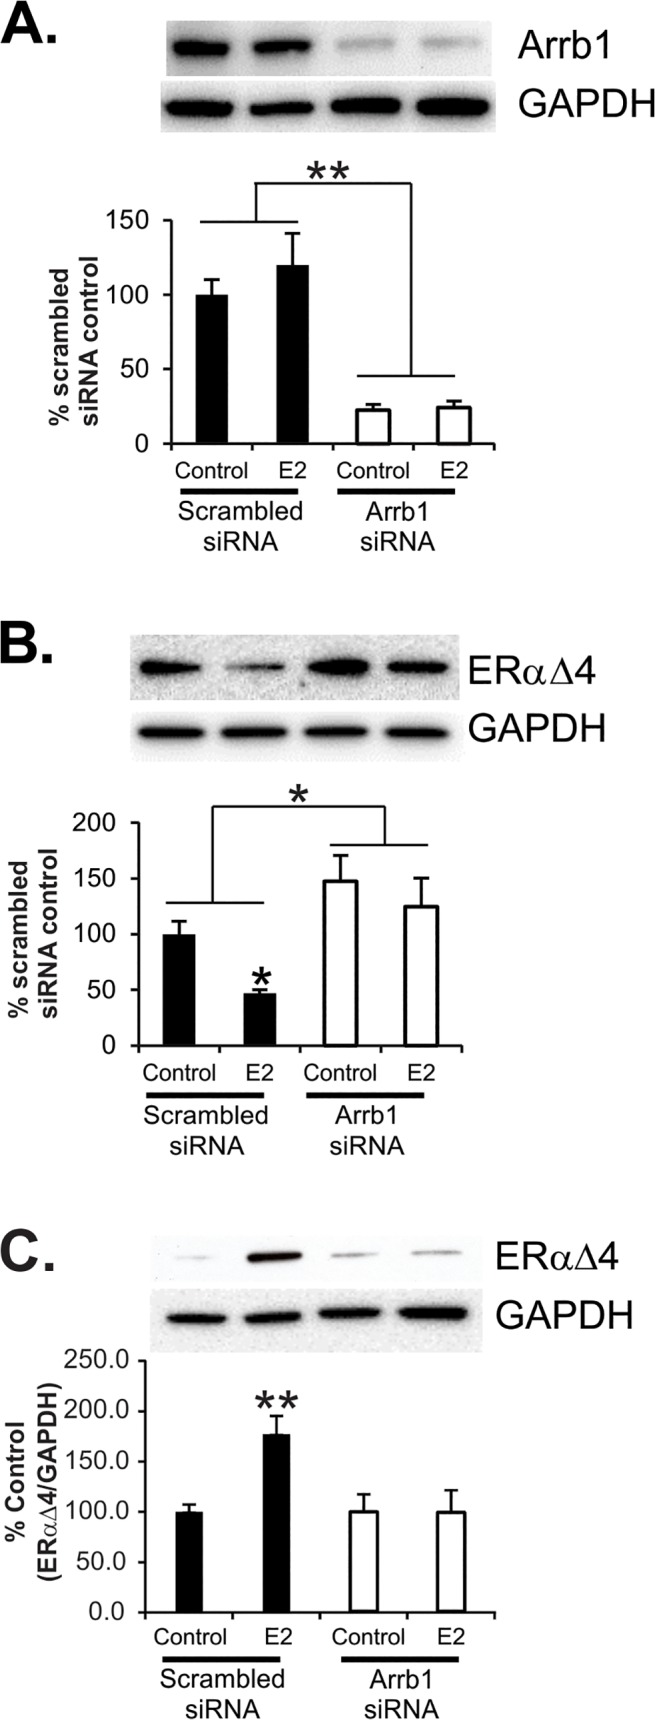
N-38 cell surface protein biotinylation and internalization after transfection with scrambled siRNA (control) or Arrb1 siRNA and estradiol (E2) treatment.(A) Arrb1 protein levels in N-38 cells transfected with scrambled siRNA (50 nM) vs. Arrb1 siRNA (50 nM) at 72 h post-transfection. (B) Cell surface mERαΔ4 levels in scrambled siRNA-transfected vs. Arrb1 siRNA-transfected cells in unstimulated cells or cells treated with E2 (1 nM for 2 h). (C) Internalization of mERαΔ4 in scrambled siRNA-transfected cells treated with E2 for 30 min vs. Arrb1 siRNA-transfected cells stimulated with E2. Values represent means (n = 6–7 experiments) ± SEM. *(p<0.05). **(p<0.005).